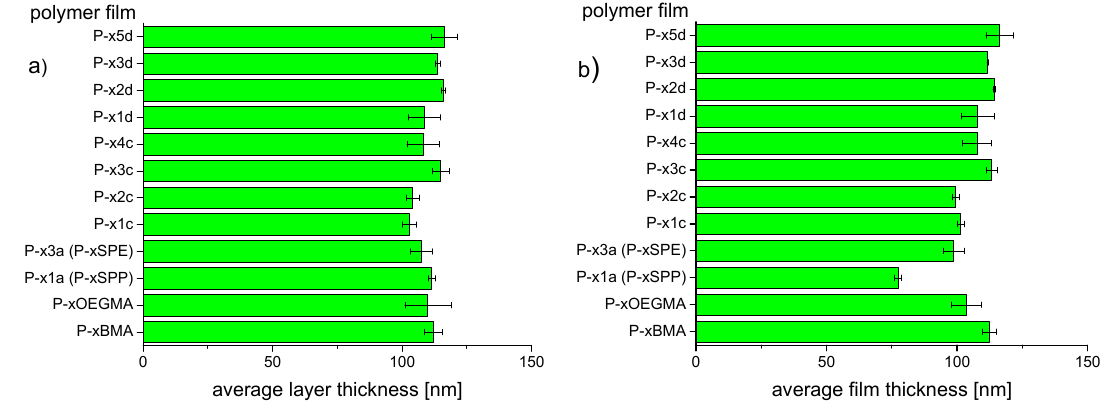
Figure 5. Ellipsometric thickness of dry polyzwitterion films: ( a ) measured after photo-curing, and ( b ) measured after the subsequent washing procedure.